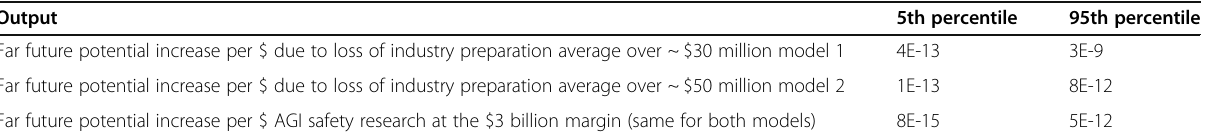
Table 2 Cost-effectiveness comparison